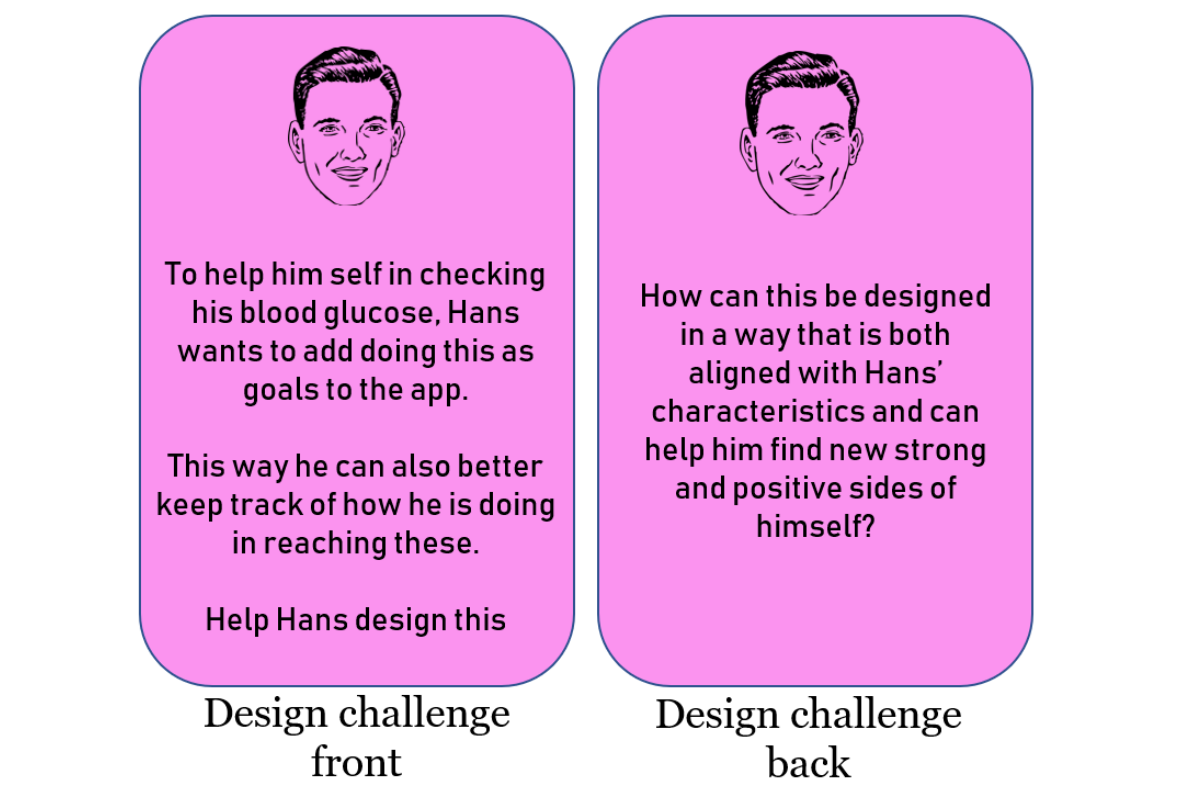
Figure 4. Cards for design game